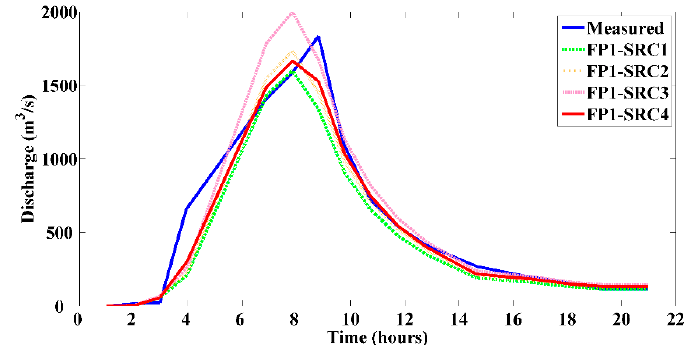
Figure 5. Comparison of the measured and simulated FP1 under the four SRCs.